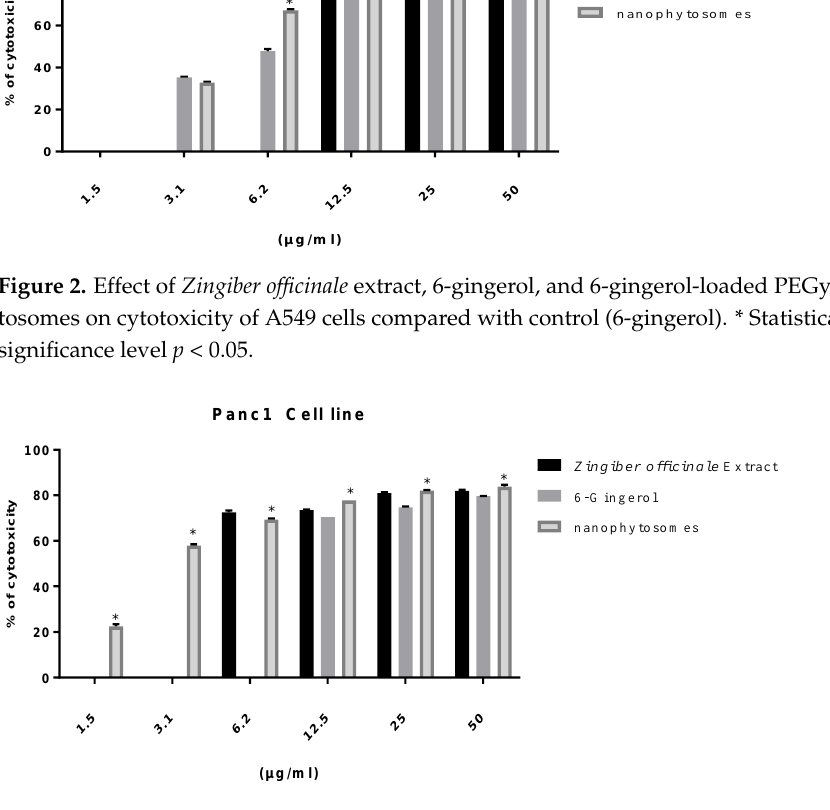
* * Figure 4. Effect of Zingiber officinale extract, 6-gingerol, and 6-gingerol-loaded PEGylated nanophy- tosomes on cytotoxicity of human periodontal ligament fibroblast cells compared with control (6- gingerol). * Statistically different at significance level p < 0.05. 3.2.3. Gene Expression of Pro-Inflammatory Cytokines We determined the gene expression levels of the cytokines in ginger crude extract and the loaded PEGylated nanophytosomes (1.5 µg/mL) with the authentic 6-gingerol us- ing RT-PCR technology. The cytokines we examined were TNF- α, IL -1beta, IL-6, IL-8, IL- 10, and IRAK1. The breast cancer MDA-MB-231 cell line elicits the production of proinflammatory cytokines TNF- α, IL -1beta, IL-6, IL-8, and IL-10. Our analysis of IRAK1.RT-PCR expres- sion levels revealed that the crude extract as well as the pure compound 6-gingerol have significantly ( p < 0.05) downregulated factors (TNF- α, IL -1beta, IL-6, IL-8, and IRAK1) in MDA after being separately loaded in PEGylated nanophytosomes (Figure 5).